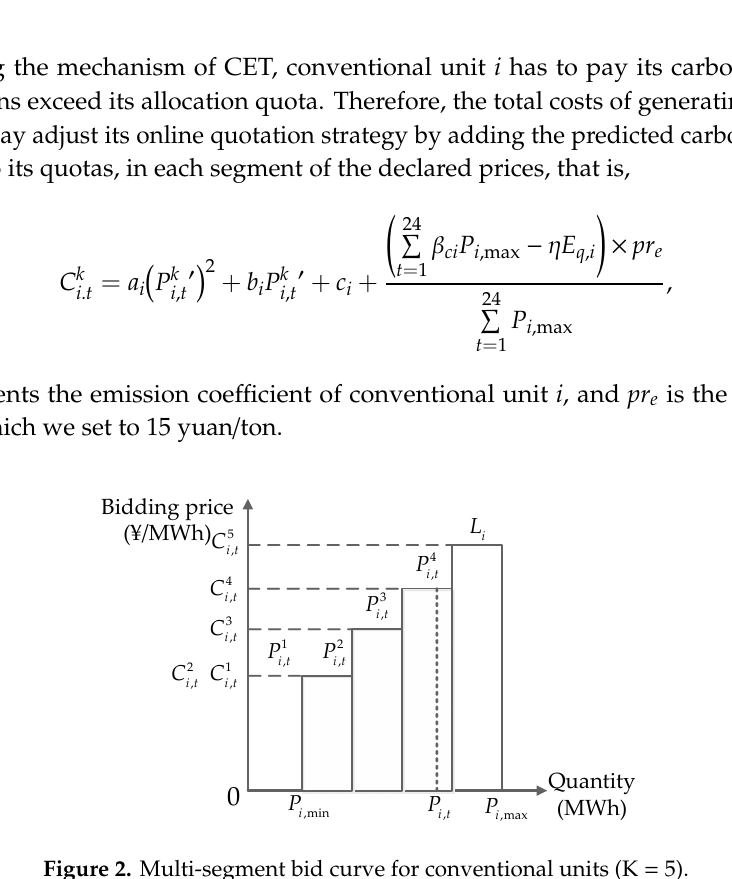
Figure 4. Pareto front, Utopia line, and normalized objective space.